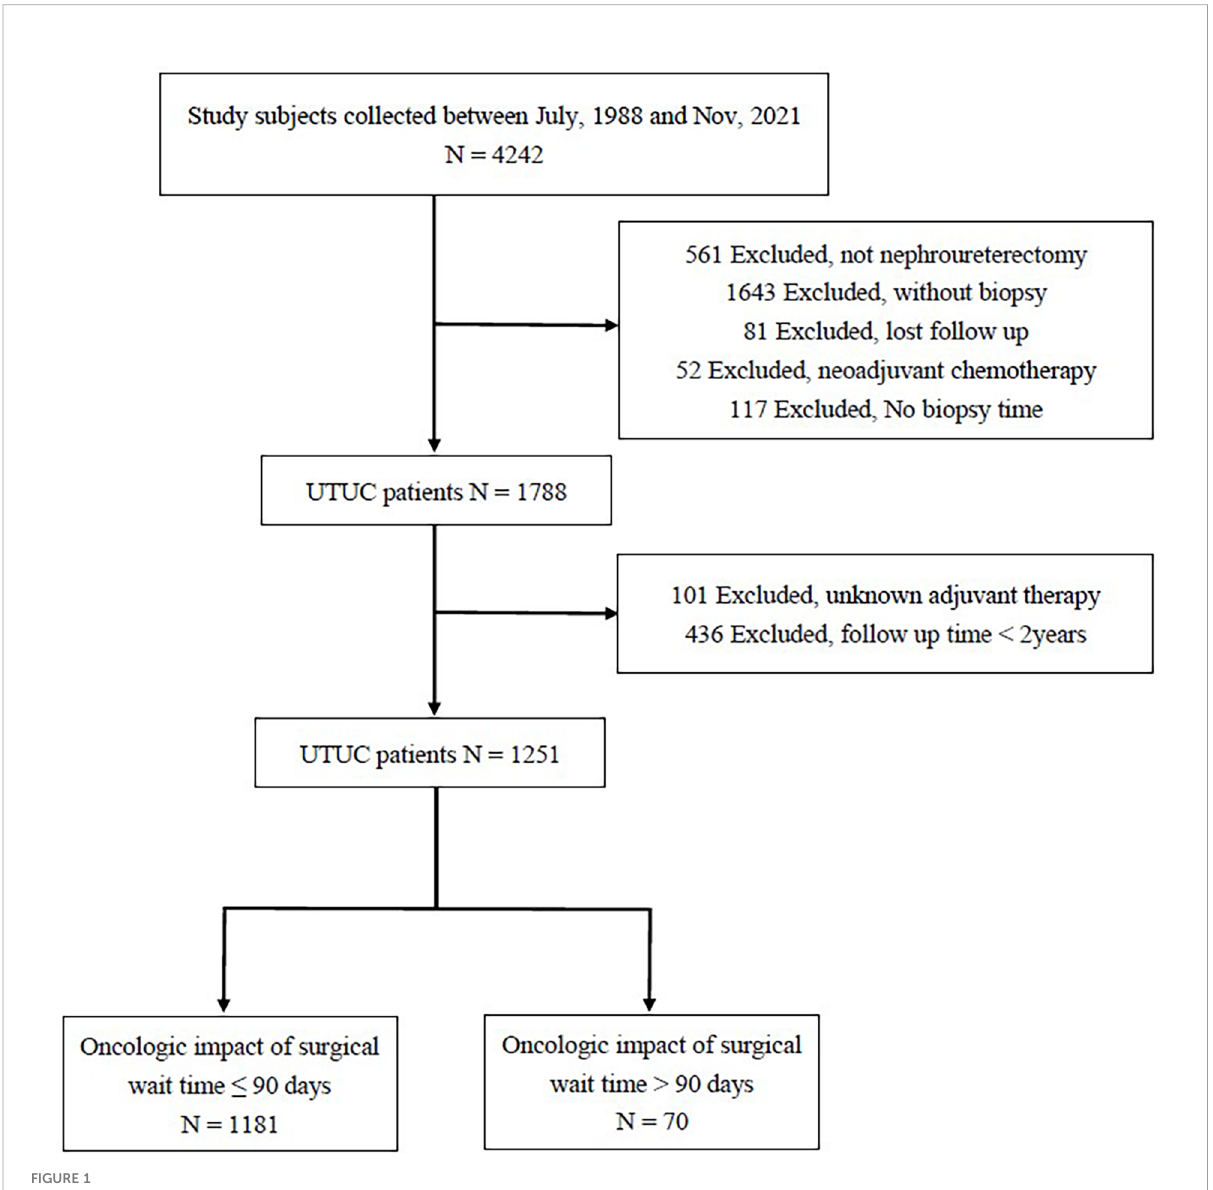
FIGURE 1 Patient fl ow diagram for UTUC